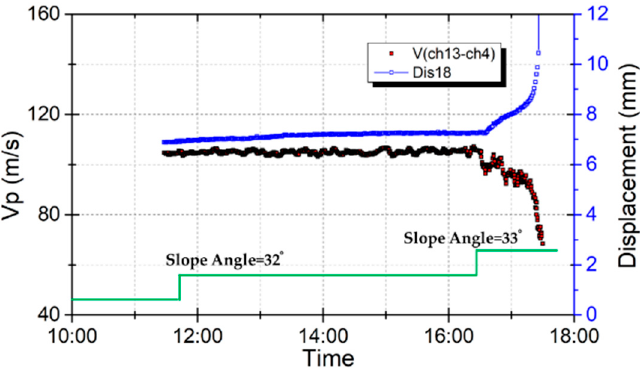
Figure 16. Effect of wave velocities on displacement during an applied shear force.